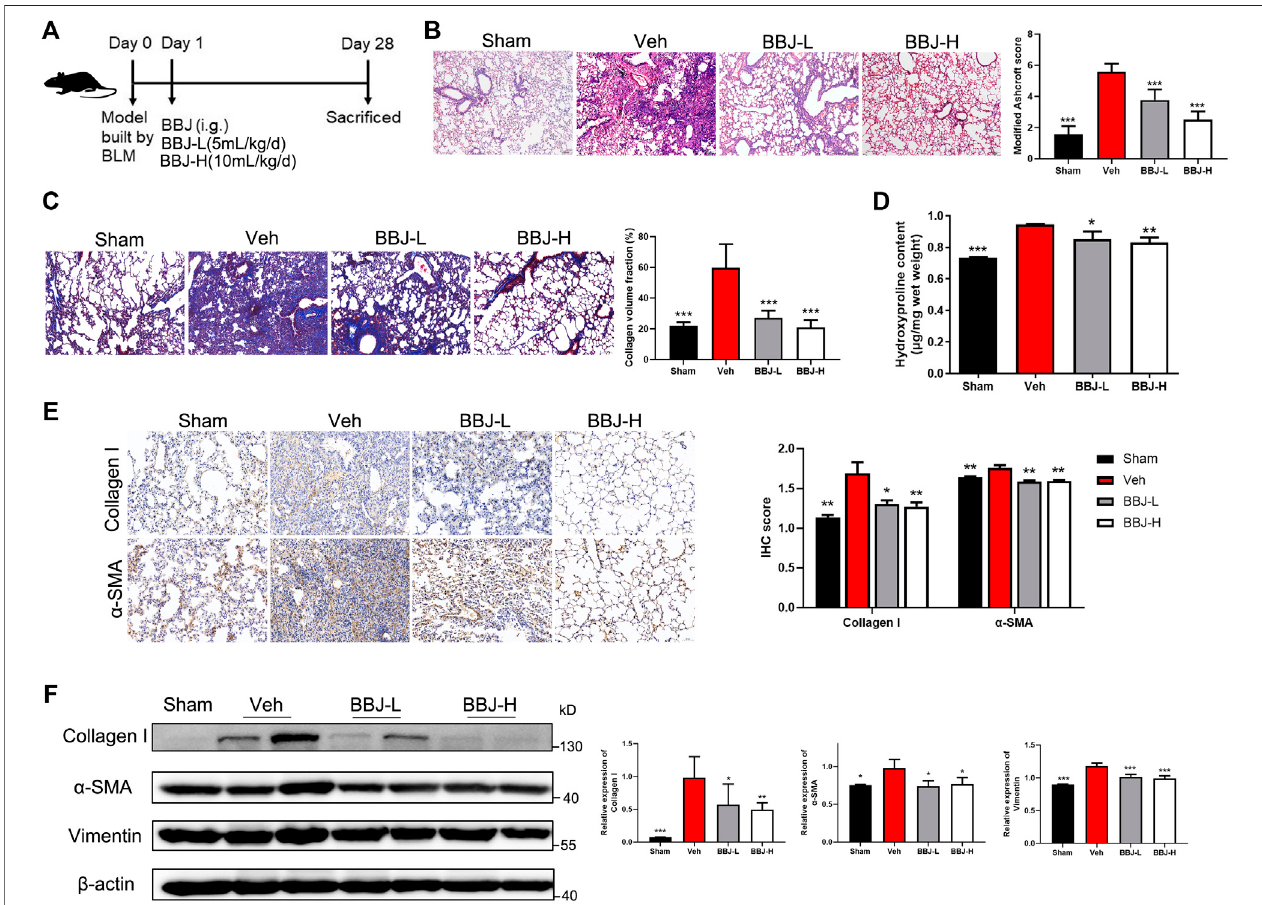
FIGURE 5 | The BBJ could prevent fi brosis formation induced by BLM in mice. (A) Arrangement of animal study in the prevention model. The fi brosis model was built by tracheal injection of BLM on day 0. Next day, vehicle and BBJ-fed groups were administrated by saline and BBJ for 4 weeks, respectively. (B) Lung sections of each group were stained with H&E (×10). Modi fi ed Ashcroft scores were applied to evaluate the degree of pulmonary fi brosis. (C) Lung sections of each group were stained by Masson trichrome (×10). Collagen volume fractions were analyzed from the results of Masson-stained lung sections by ImageJ. (D) Hydroxyproline contents were tested by the hydroxyproline assay kit. (E) The expressions of collagen-I and α -SMA in lung sections were detected by IHC staining, and these proteins ’ expressions were calculated by ImageJ. (F) Expressions of collagen-I, α -SMA, vimentin, and β -actin in lung tissues of each group were analyzed by western blotting. ImageJ software was used to calculate these proteins ’ expressions. * p < 0.05; ** p < 0.01; *** p < 0.001 compared with the vehicle group.